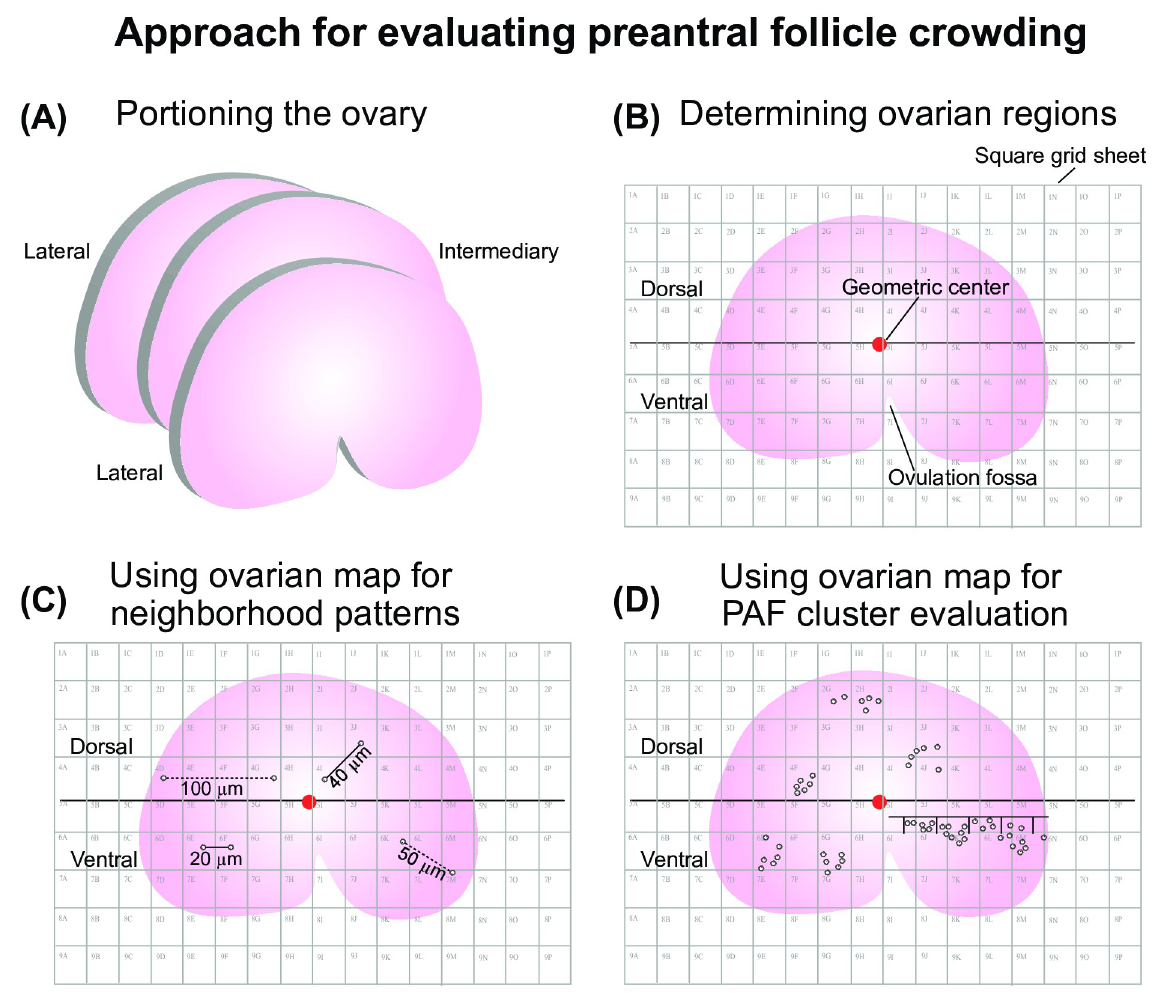
Fig 1. Illustration of procedures performed to assess the neighborhood and clustering patterns of equine preantral follicles. (A) Ovaries were divided into three portions (lateral, n = 2; intermediary, n = 1) and then histologically processed. Once sections of the ovaries were mounted onto microscope slides, (B) a square grid sheet (area of each square = 0.0625 cm 2 ) with columns and rows labelled with numbers and letters, respectively, was placed onto each slide. The geometric center was then determined, and a longitudinal line was drawn through the center to define the dorsal (all areas above the longitudinal line) and ventral (all areas below the longitudinal line) regions. From this point on, the slide is referred to as an “ovarian map.” Ovarian maps were used to evaluate (C) neighborhood patterns, where preantral follicles within 40 μ m of each other (indicated by solid lines) were considered to be neighbors, while follicles further than 40 μ m were not considered to be neighbors (indicated by dashed lines), and (D) clustering, which was calculated considering the number of follicles in five consecutive T- shaped plots (not to scale) using the formula for Morisita’s index of